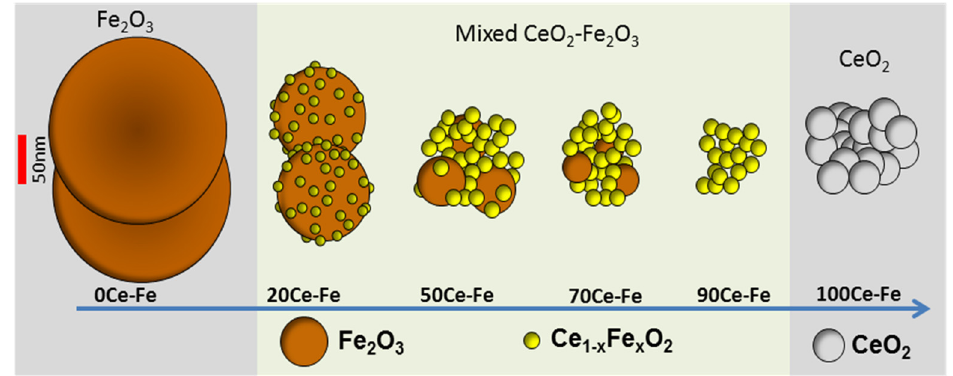
Figure 5. Scheme of a series of mixed CeO 2 –Fe 2 O 3 samples, composed on the basis of inductively coupled plasma (ICP) composition, XRD, STEM, EDX and EELS analysis [53].